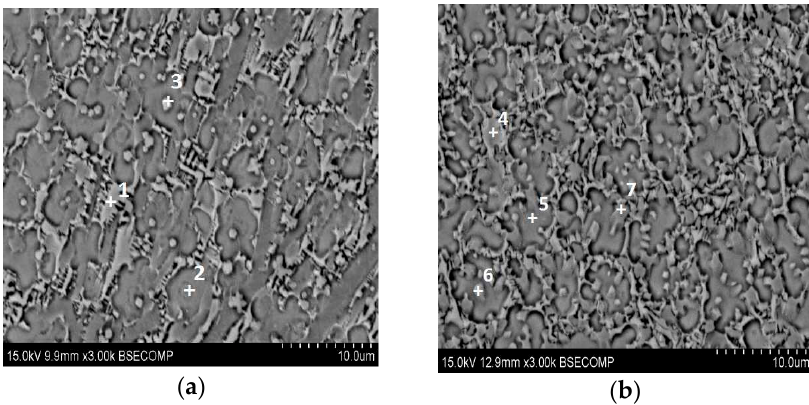
Figure 7. Microstructures of phases in coatings: ( a ) coating 1; ( b ) coating 4. Table 3. EDS analysis results of the phases in coating 1 and coating 4 (at %).